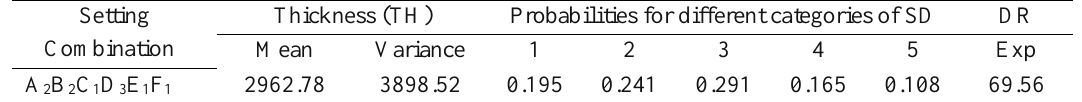
Table 2. Predicted mean and variance of TH, probabilities for different categories of SD and the expected value of DR at the chosen arbitrary setting